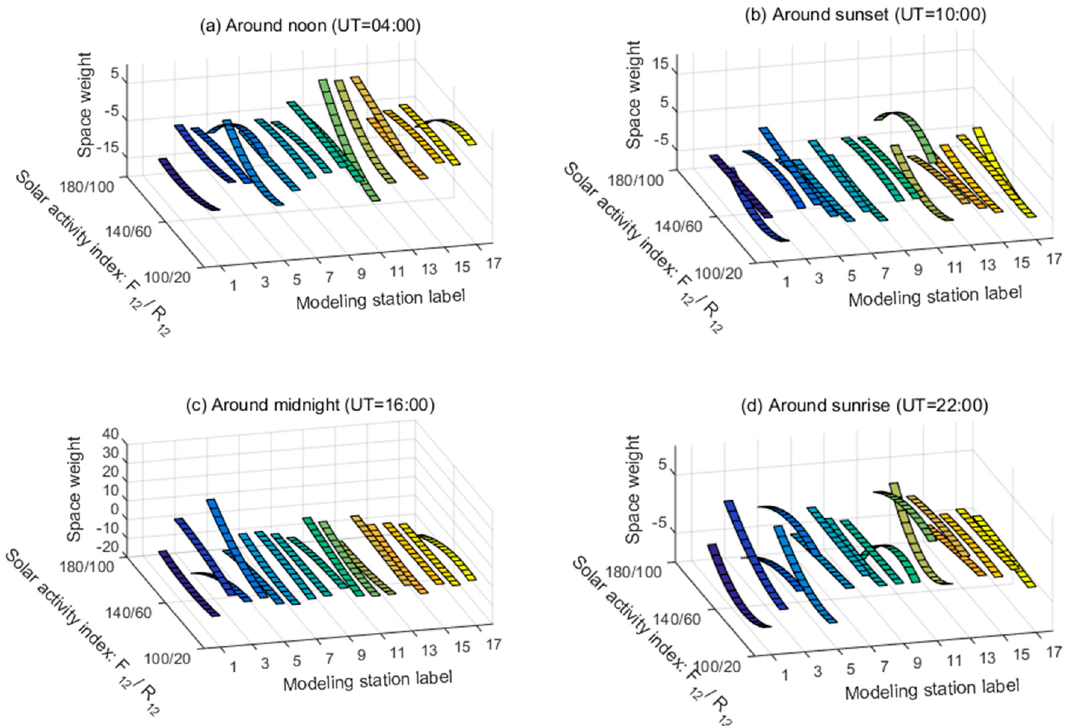
Figure 9. The sample maps of space weights with measured stations. Measured station labels from 1 to 17 are Akita, Beijing, Chongqing, Guangzhou, Haikou, Irkutsk, Khabarovsk, Magadan, Manzhouli, Okinawa, Seoul, Taipei, Tokyo, Tunguska, Wakkanai, Yakutsk, and Yamagawa, respectively. ( a )